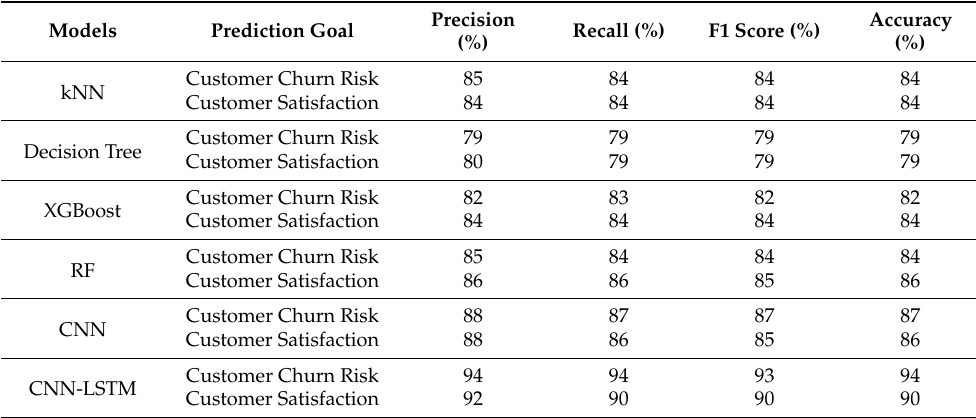
Figure 6. Accuracy (%) of different models in predicting ( a ) customer churn risk and ( b ) customer satisfaction. Table 4. Precision, recall, F1 score and accuracy of different